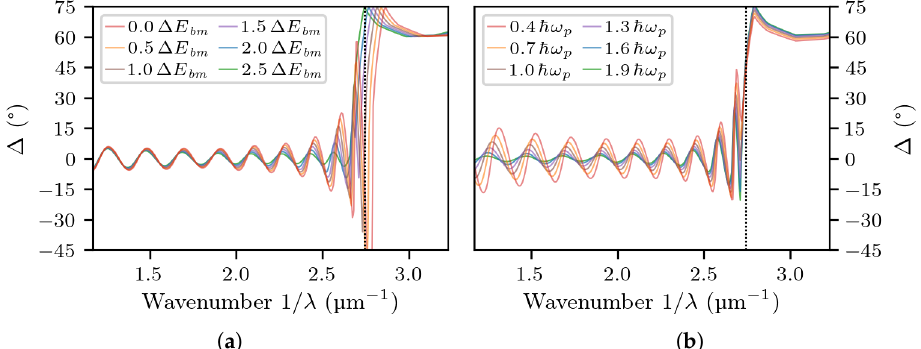
Figure 7. The simulated ellipsometric parameter ∆ for the structure of Sample A , obtained by decreasing or increasing the parameters ∆ E bm ( a ) and ¯ h ω p ( b ). Note that the former affects the ∆ curve most at high energies (i.e., close to the bandgap), whereas the latter affects the ∆ curve most at low energies (i.e., closer to the plasma frequency ¯ h ω p ).